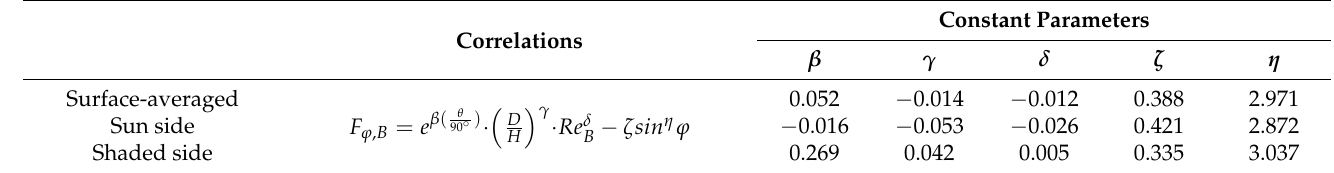
Table 5. Correlations to calculate surface-averaged Nu for the louvered façade with different louver angles φ.